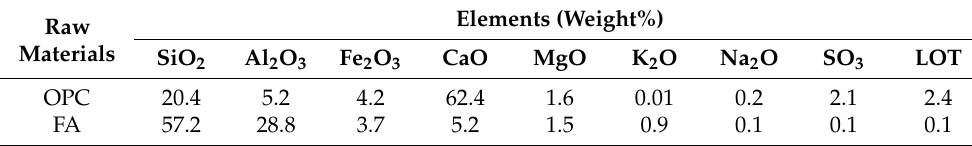
Table 1. Chemical compositions of OPC and FA obtained from XRF